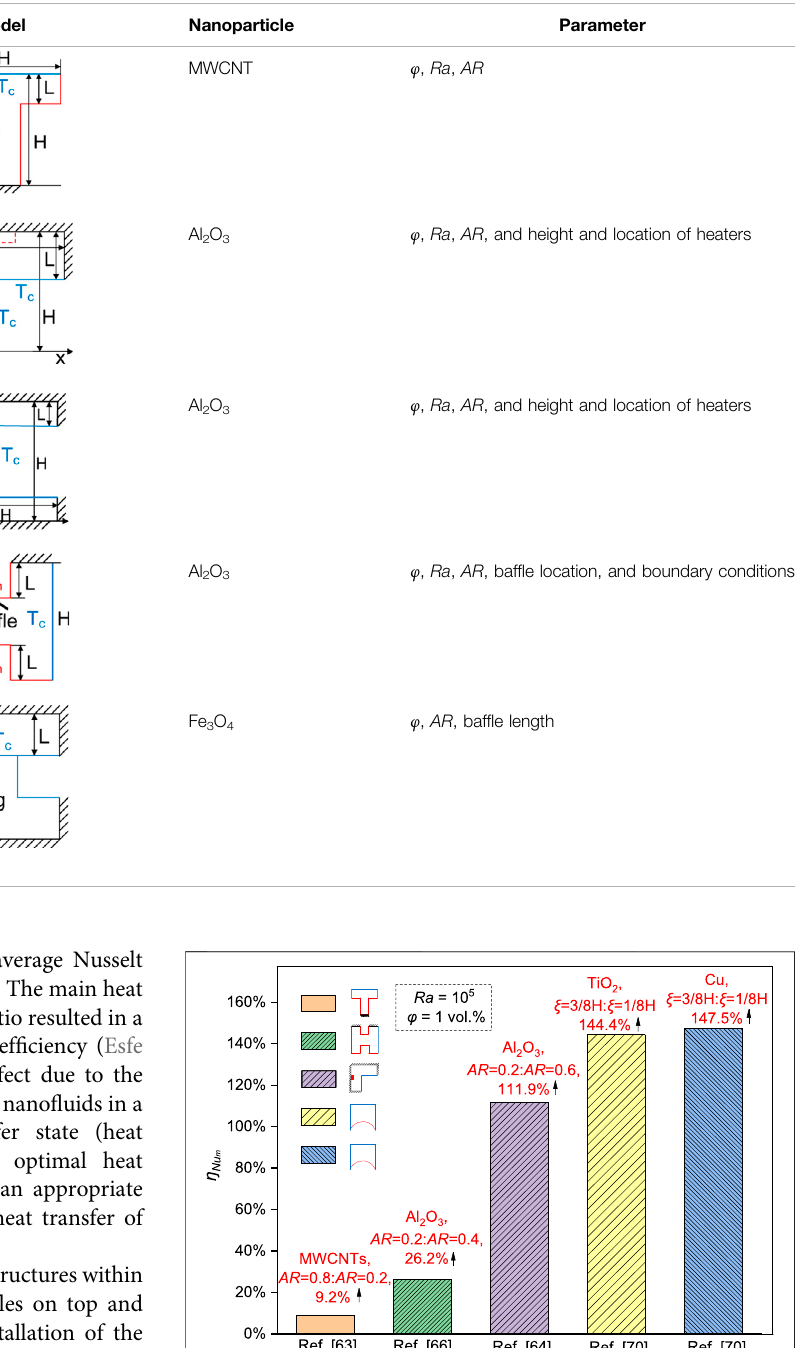
TABLE 5 | Information of water-based nano fl uids inside non-conventional